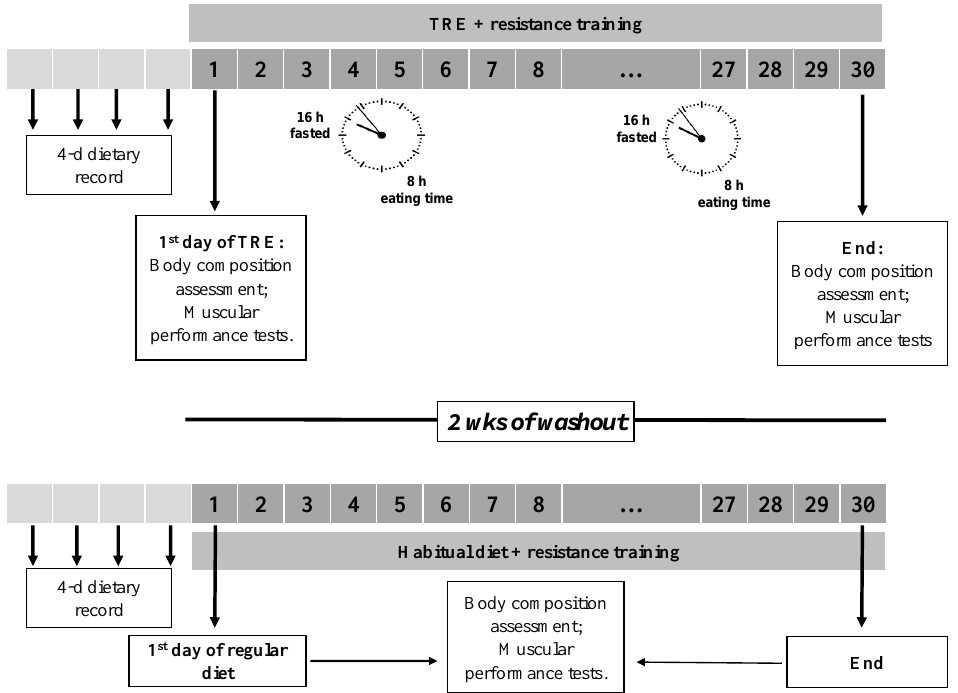
Figure 1. Schematic representation of the study protocol. The experimental design consisted of two dietary interventions involving four weeks of time-restricted eating (TRE) and non-time-restricted eating (non-TRE). TRE interventions followed a 16/8 time-restricted feeding protocol. The order of dieting was randomized and counterbalanced, and two weeks of washout separated both condi- tions. Baseline dietary records were obtained prior to each dietary intervention. Body composition assessments and muscular performance tests were performed in consecutive days at baseline and after four weeks of intervention under both conditions. The participants were required to follow a structured training routine during each dietary intervention (three weekly sessions of four sets of 8–10 repetitions at 85% of the 1-RM leg press, bench press, leg extension, leg curl, shoulder press and lat